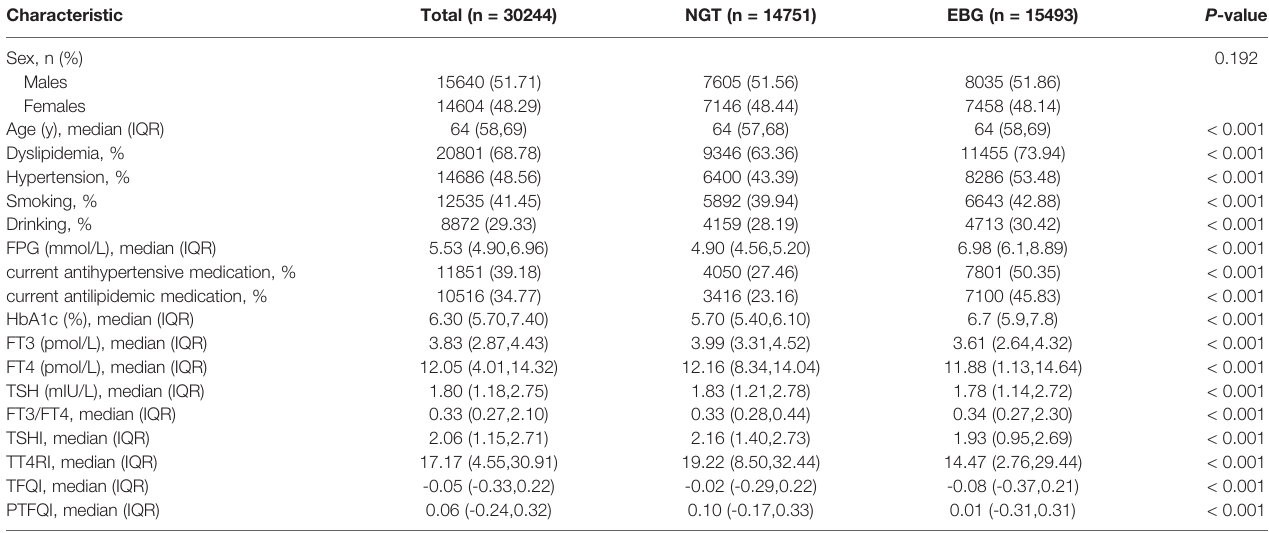
TABLE 1 | Baseline